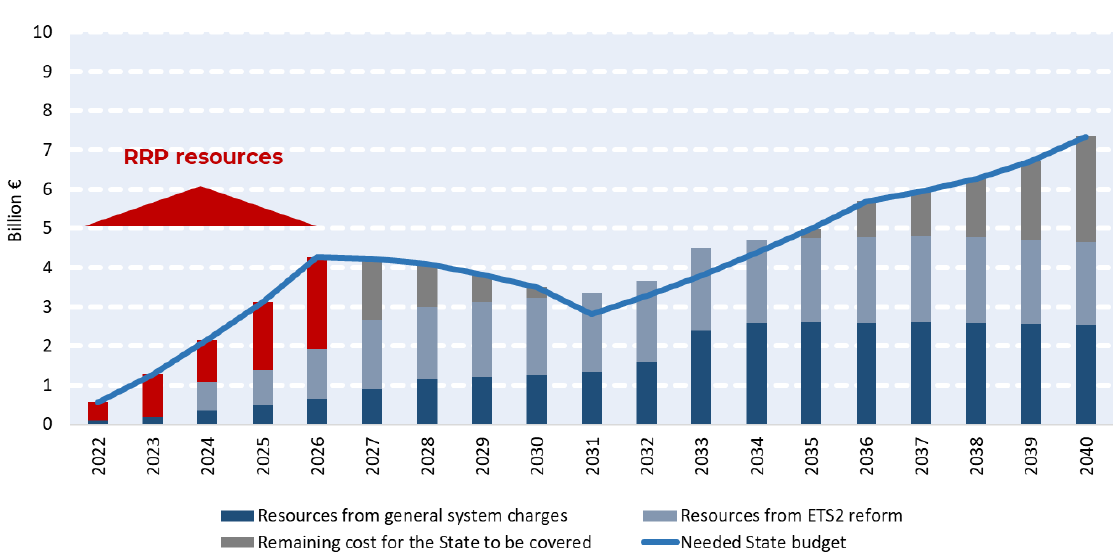
Figure 6. Evolution of the state cost for the proposed scheme and hedging resources due to the general system charge reform and the ETS2 mechanism.